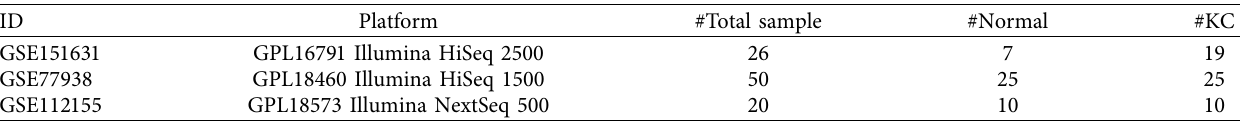
Table 1: The expression profile data of each dataset before merging, and the data format is the gene read count expression level after standardization under the detection platform of each